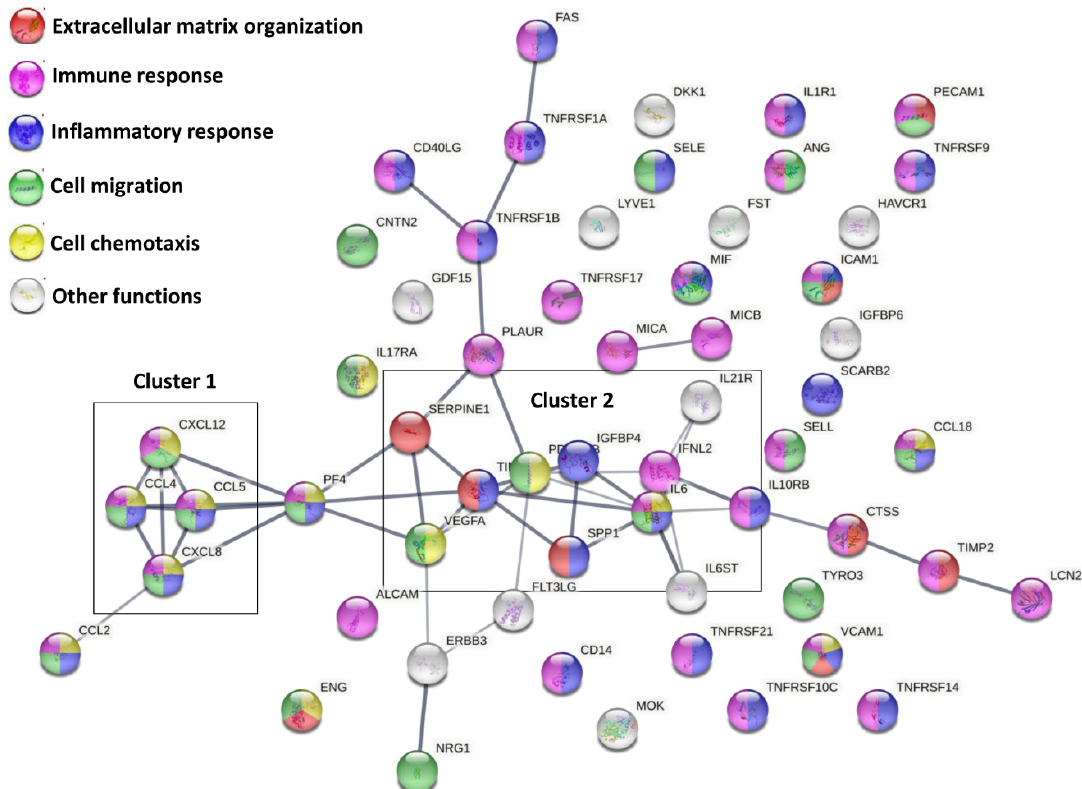
Figure 2. Functional association network for ELISA-detected secreted factors. Using the online tool STRING, protein–protein interaction levels for 58 proteins of the ASC secretome after OA-SF treatment were mined. Legend: factors involved in Extracellular matrix organization, red nodes; Immune response, purple nodes; Inflammatory response, blue nodes; Cell migration, green nodes; Cell chemotaxis, yellow nodes. Edges represent protein–protein associations, with thickness representing Edge confidence (medium: 0.400, high: 0.700, highest: 0.900). Empty nodes: proteins of unknown 3D structure; filled nodes: some 3D structure is known or predicted.